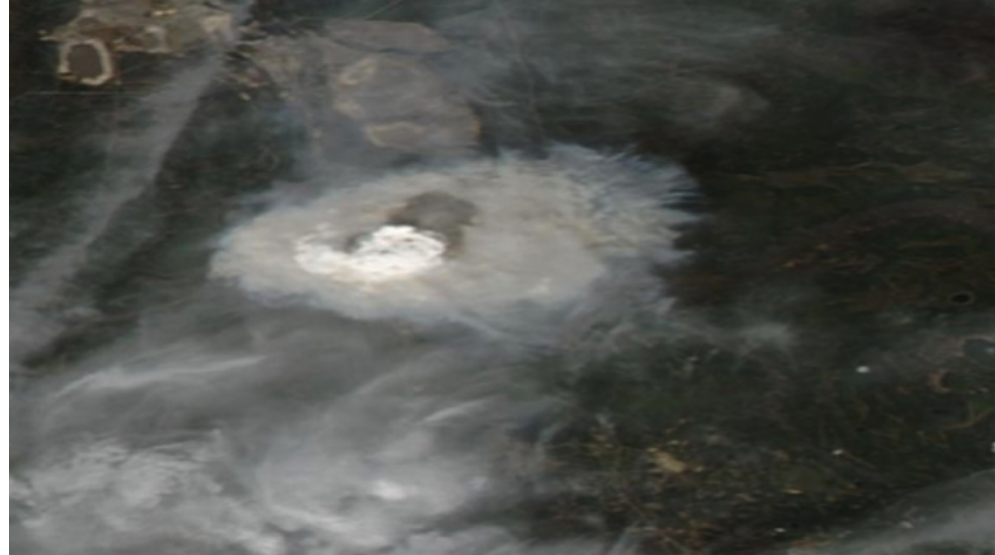
Figure 11. NASA (Aqua/Moderate Resolution Imaging Spectroradiometer (MODIS)) image on May